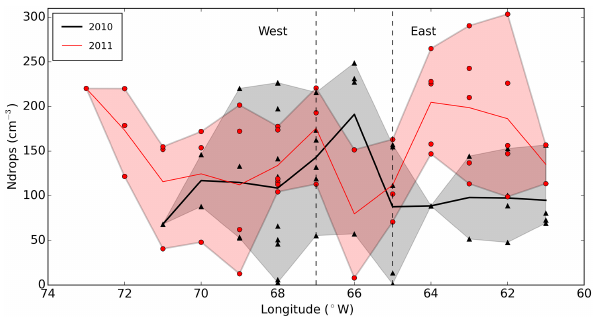
Figure 6. Same as Fig. 4 but for the liquid droplet number concen- tration (cm − 3 ).